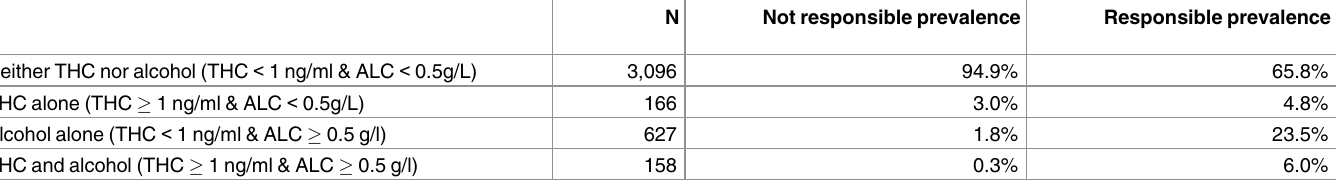
Table 6. Number and prevalence for isolated or combined influences for responsible and non-responsible drivers (n = 4,047 * ,data source Voiesur